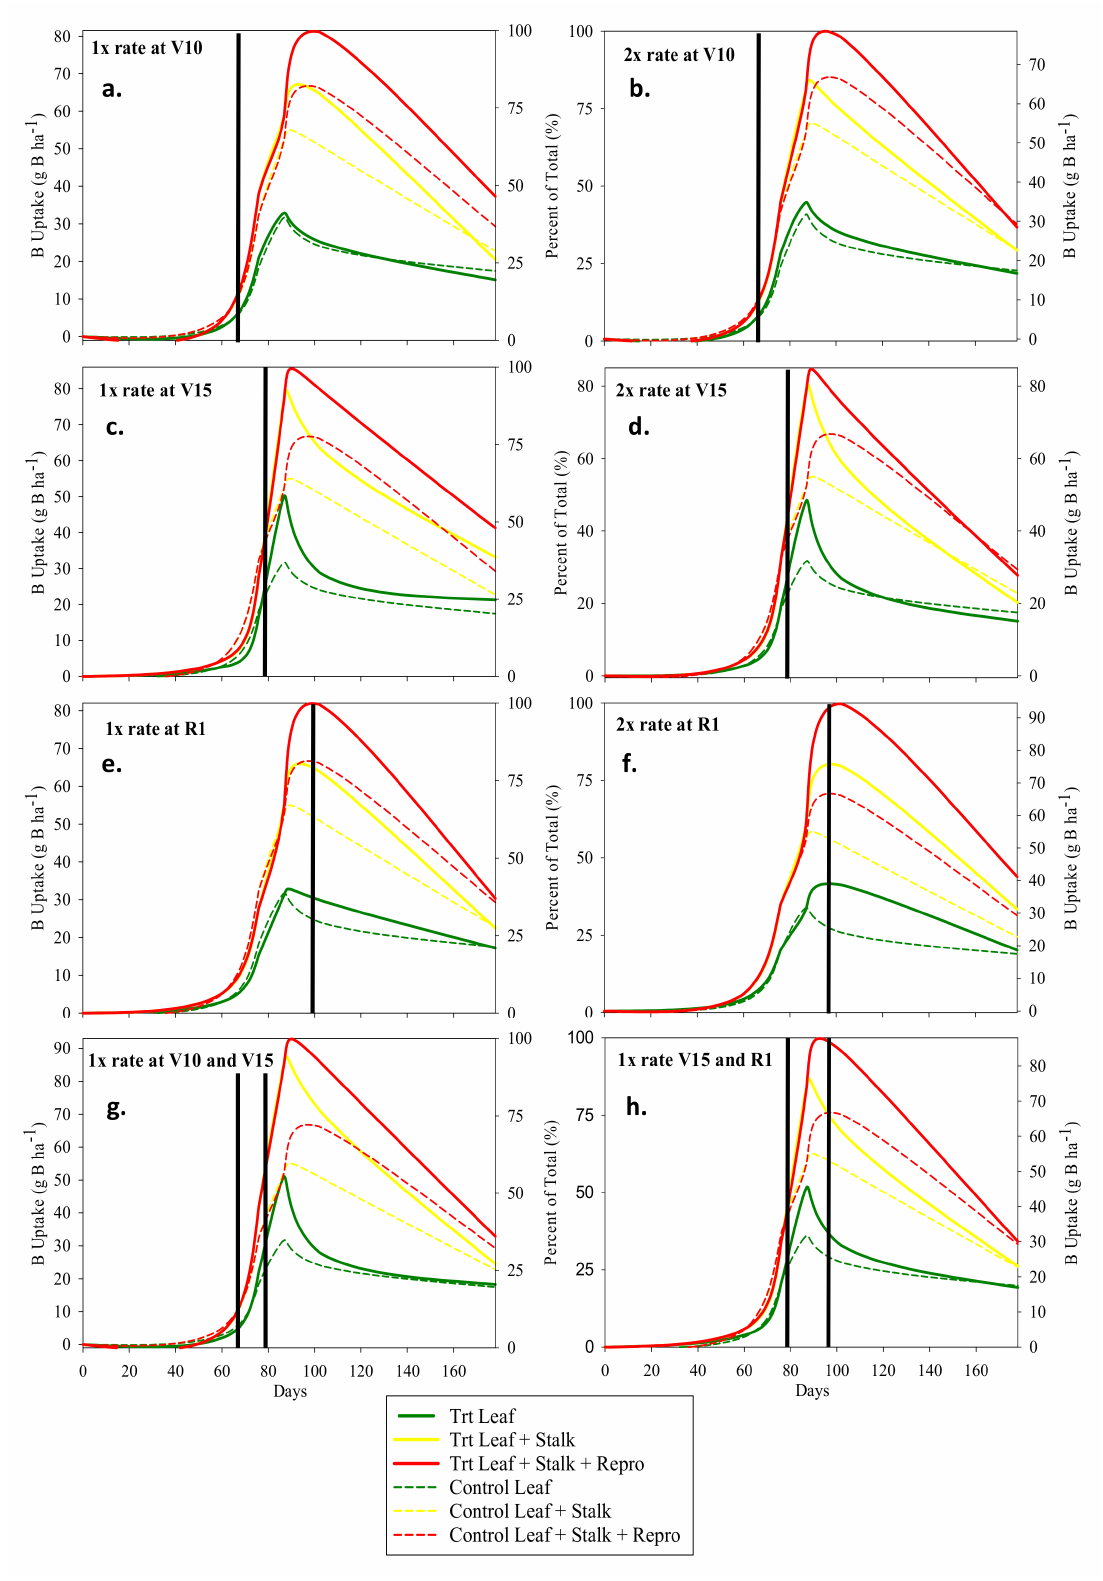
Figure 3. B uptake (g B ha − 1 ) and partitioning graphs. Solid and dashed lines represent foliar B treated plots and control plot, respectively. Solid vertical lines represent the time of application expressed as days after sowing. ( a – h ) corresponds with the